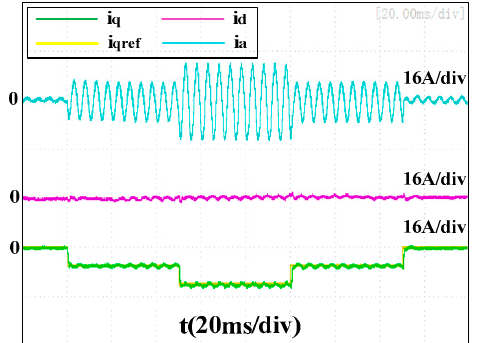
Figure 23. d-q axis current waveform of the proposed accurate discrete current controller at 12,000 rpm with Kdq = 500 π Ls , ˆ L s = 0.8 L s .